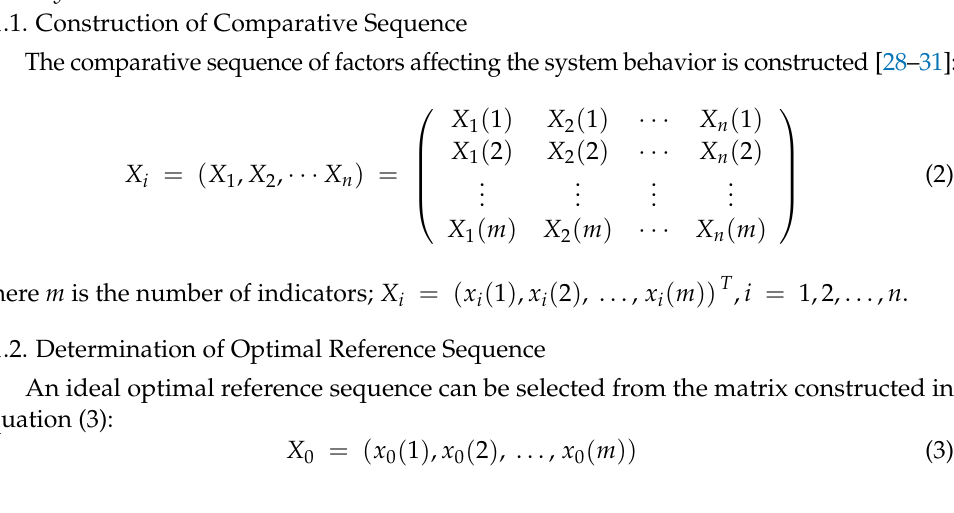
Mining thickness